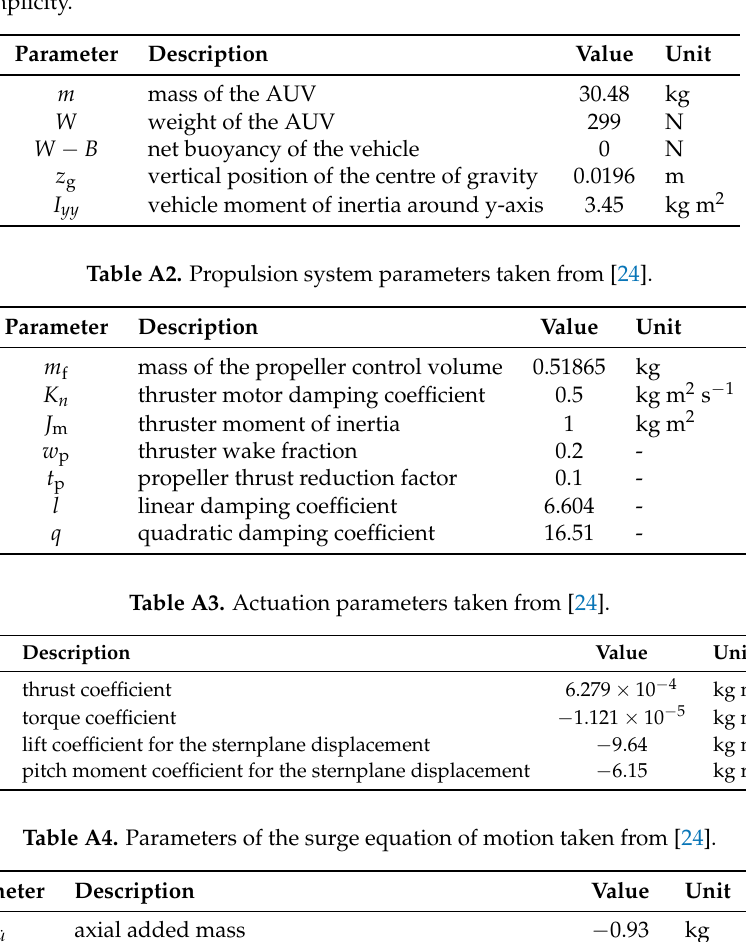
Table A1. General vehicle parameters taken from [24]. Note that zero net buoyancy is assumed in this article for simplicity.